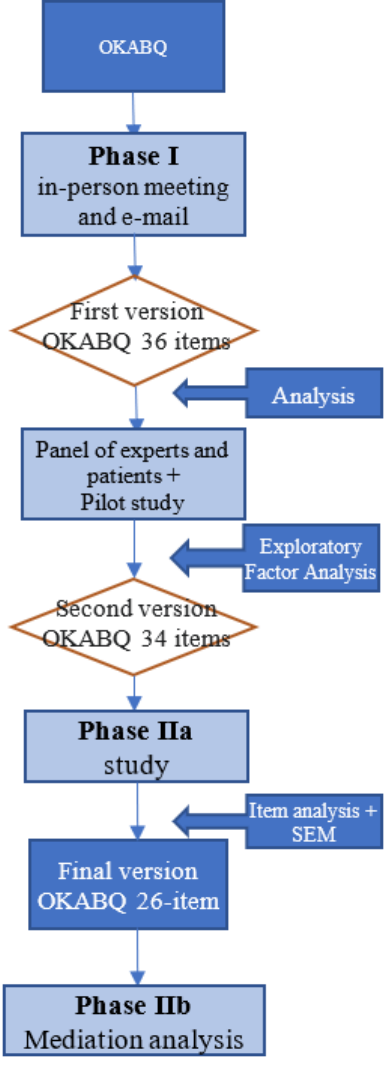
Figure 2. The procedure for the development of the OKABQ.